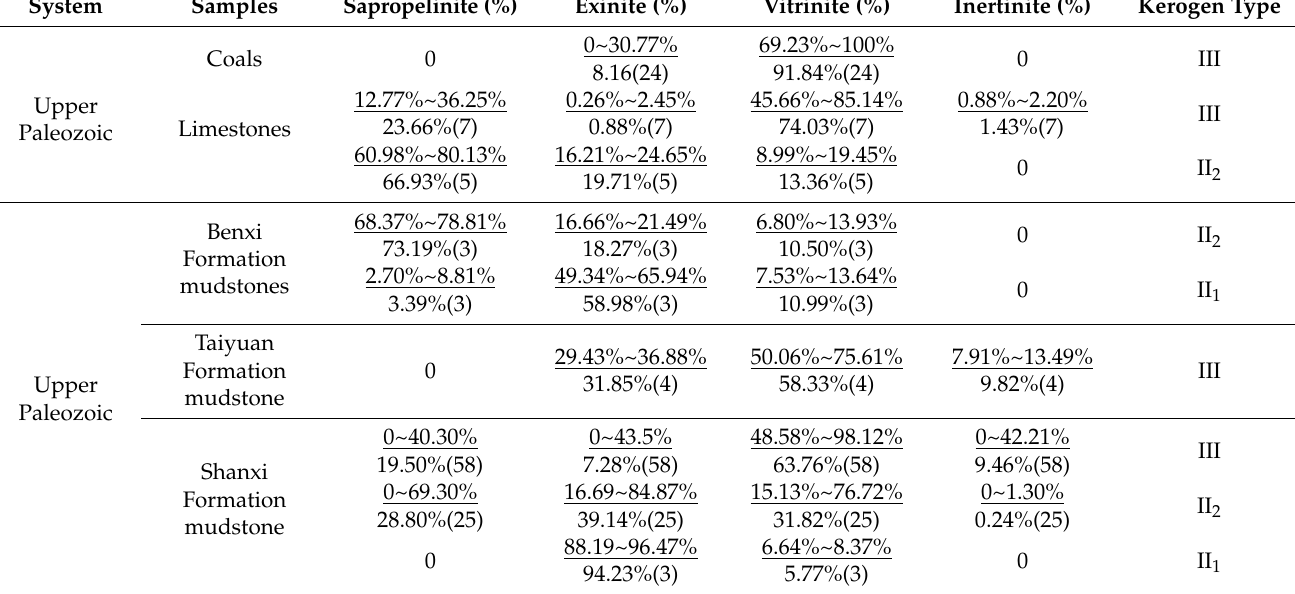
Table 2. Maceral compositions (%) and kerogen types for the source rock samples.